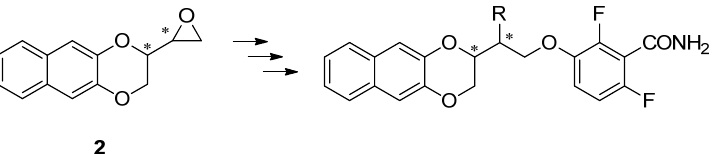
Figure 1. Structure of the epoxydic intermediate 2, starting material for the obtainment of naphthodioxane benzamide derivatives as FtsZ inhibitors (* no defined chiral center).